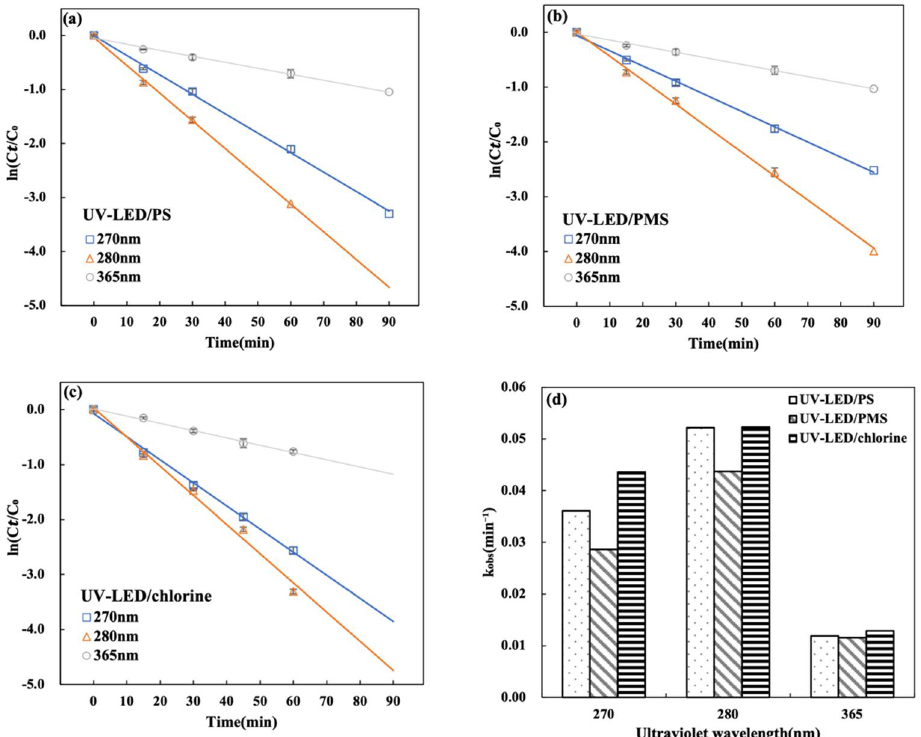
Figure 5. Effect of UV wavelength on CAP degradation during ( a ) UV-LED/PS; ( b ) UV-LED/PMS and ( c ) UV-LED/chlorine. ( d ) Comparison of k obs values. Conditions: [CAP] 0 = 5.0 mg/L, [PS] = [H 2 O 2 ] = [NaClO] = 0.5 mM, lamp power I 0 = 2.4 mW/cm 2 , t = 60 min, pH = 7.0.